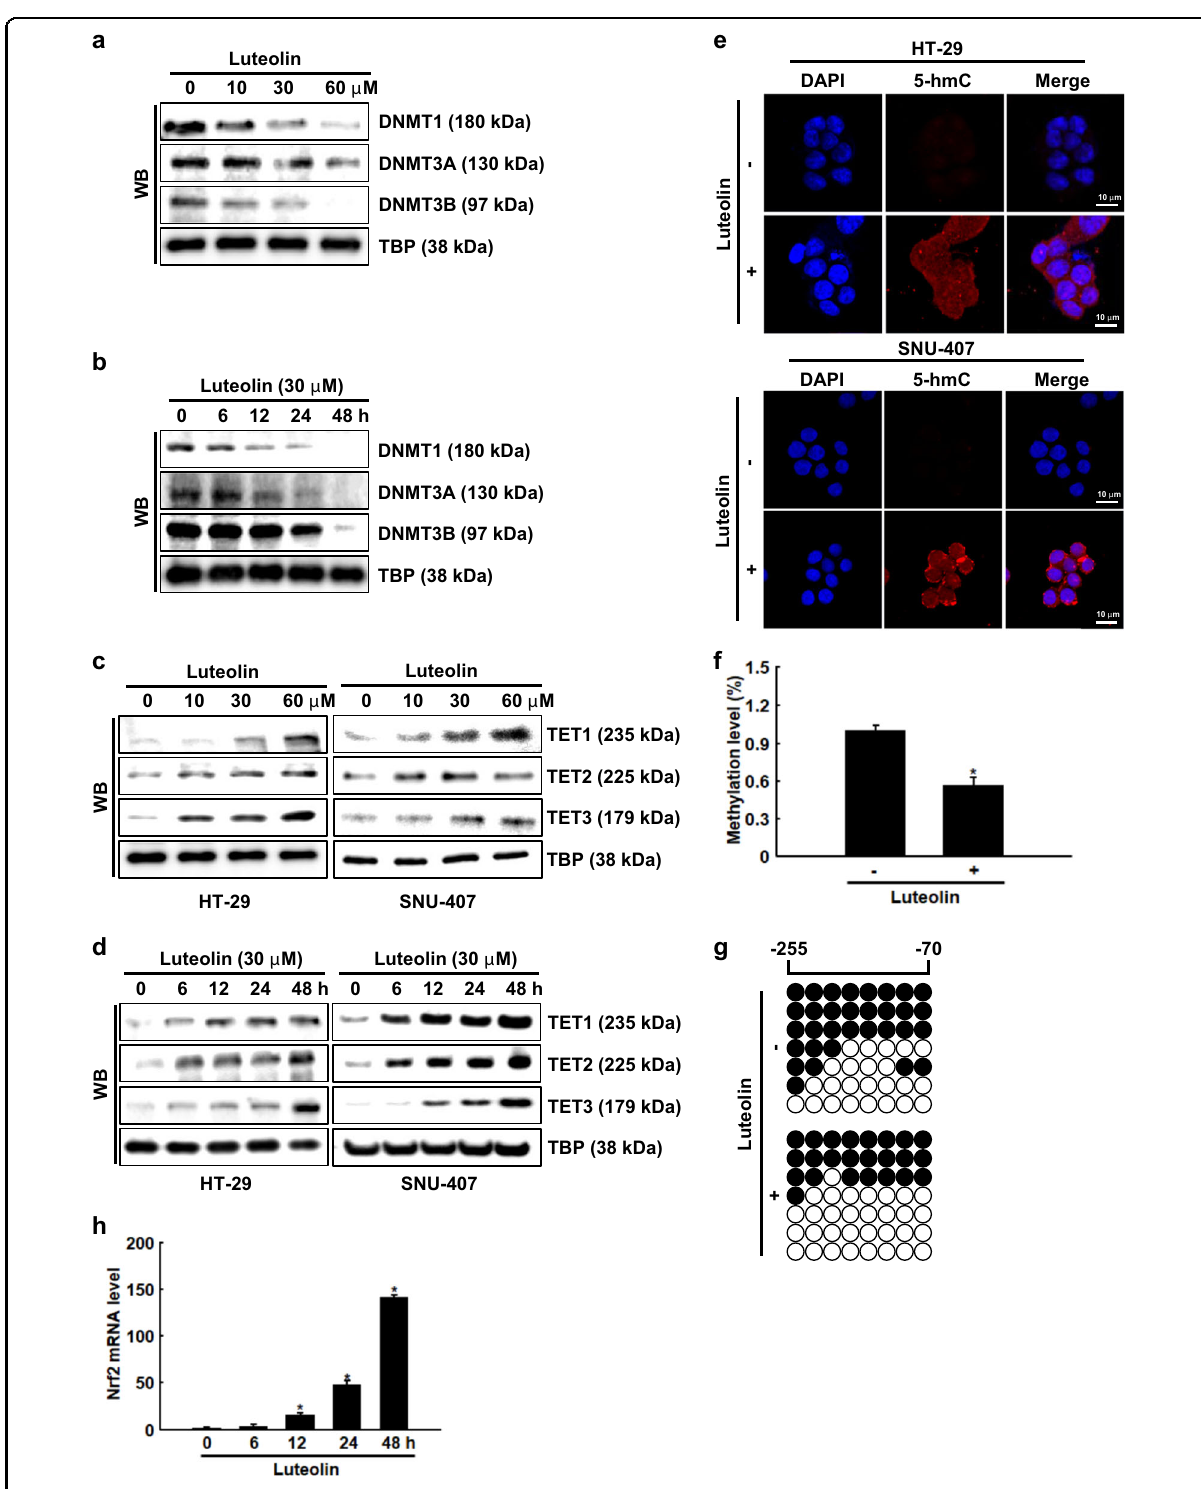
Fig. 4 Luteolin exhibits cytotoxicity by inducing epigenetic modi fi cations. Cells were treated with a , c various concentrations (0 – 60 μ M) of luteolin for 48 h or b , d 30 μ M luteolin for various durations. Western blot analysis was performed using antibodies against DNMT1, DNMT3A, DNMT3B, TET1, TET2, and TET3. e Formation of 5-hmC by TETs was assessed using confocal imaging. f MS-qPCR analysis of Nrf2 in luteolin-treated cells was performed; * p < 0.05 compared with control cells. g Bisul fi te sequencing analysis of Nrf2 promoter. Black and white circles represent methylated and unmethylated cytosine residues, respectively. h mRNA expression of Nrf2 treated with 30 µM luteolin for 0 – 48 h was assessed using real-time PCR. * p < 0.05 compared with control